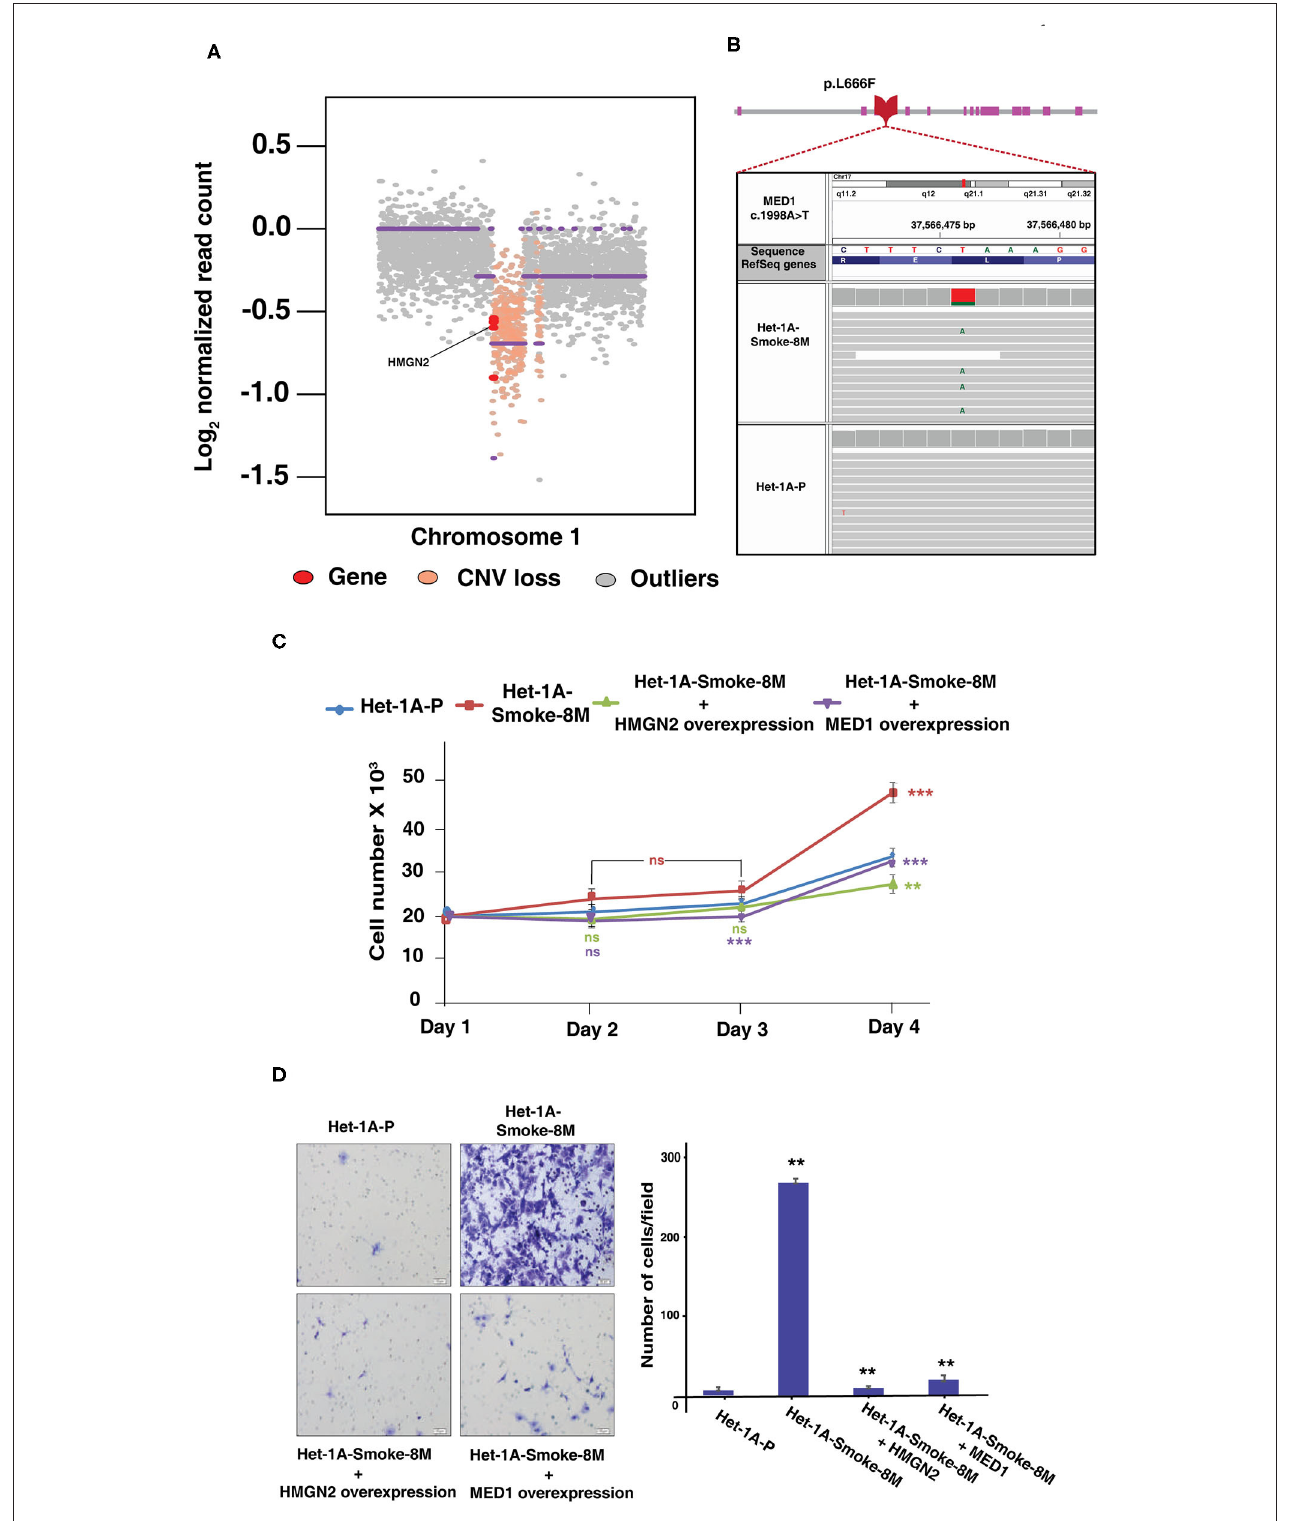
FIGURE 5 | Genomic alterations based on whole exome sequencing data. (A) Copy number loss of HMGN2 in Het-1A-Smoke-8M cells. (B) An IGV snapshot of MED1 gene representing non-synonymous SNV (pL666F). (C) Proliferation curve of Het-1A-Smoke-8M cells with and without exogenous overexpression of HMGN2 and MED1 (*** p < 0.0001, ** p < 0.01, ns, statistically not significant). (D) Invasive potential of Het-1A-Smoke-8M cells with and without exogenous overexpression of HMGN2 and MED1 (** p < 0.01).